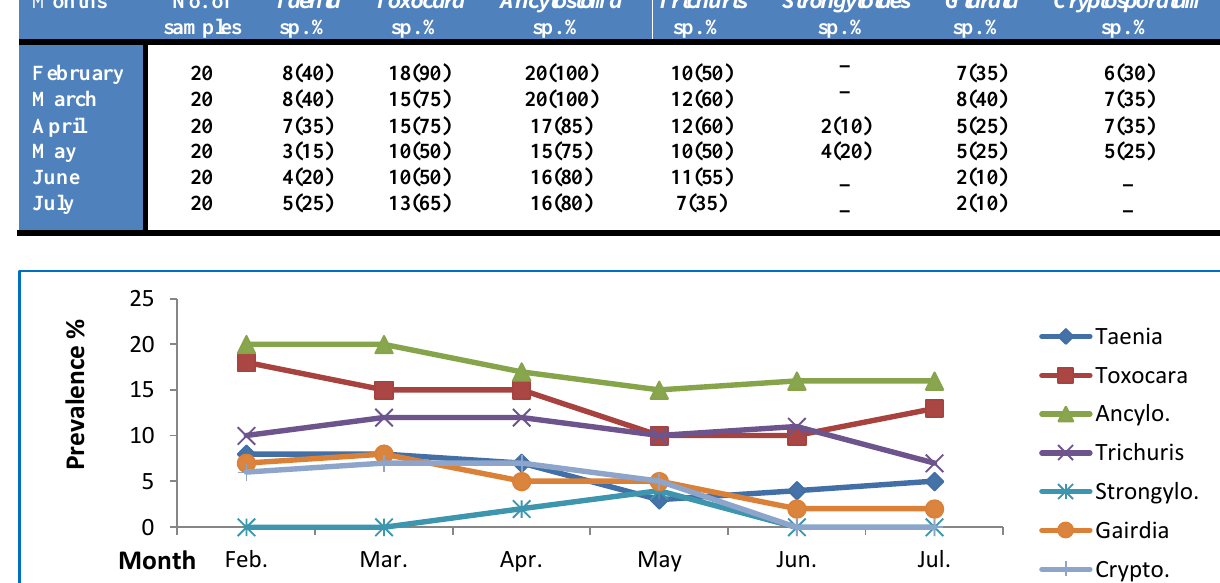
Figure, 1: Significant differences among the parasites during months of study.